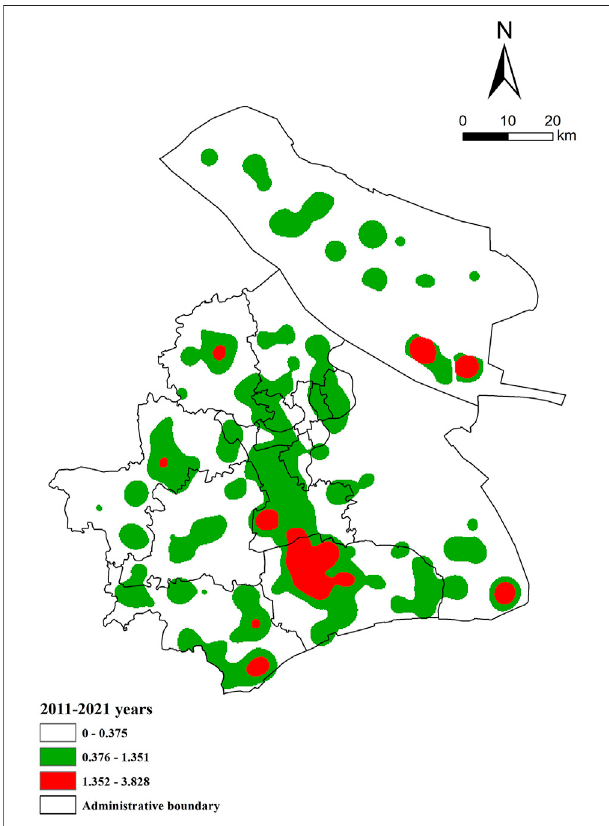
FIGURE 2 | Changes in core density of MEG entities and institutions in Shanghai.